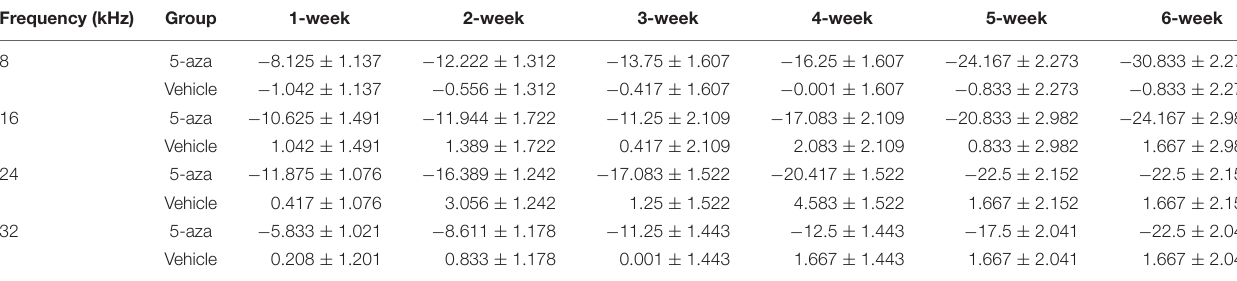
TABLE 1 | Auditory brainstem response (ABR) threshold shifts after 5-aza/vehicle treatment. Frequency (kHz)